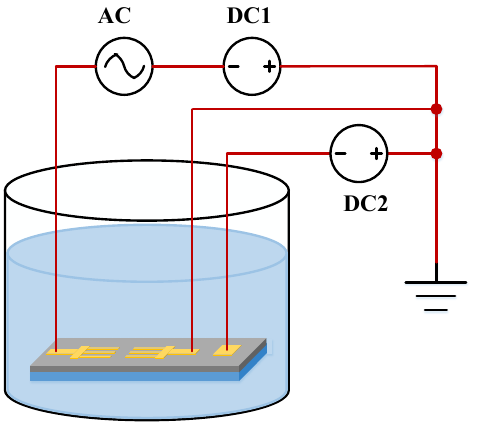
Figure 1. The electric field application method during the growth of ZnO nanowires.